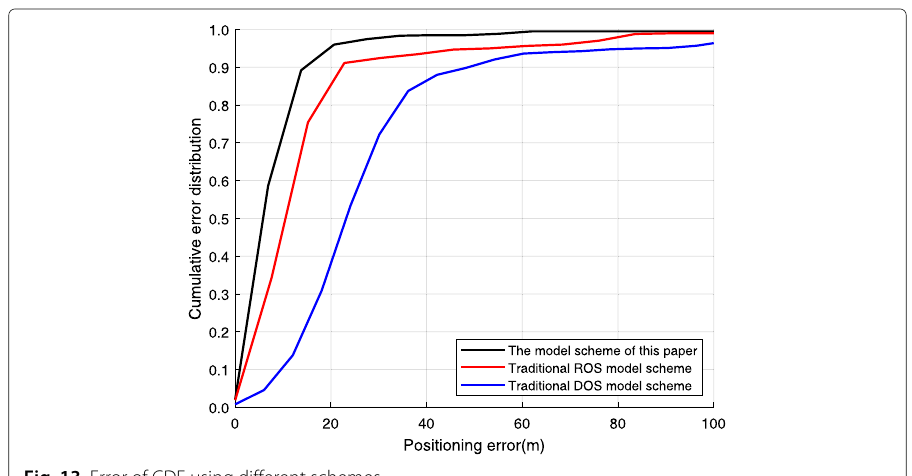
Fig. 13 Error of CDF using different